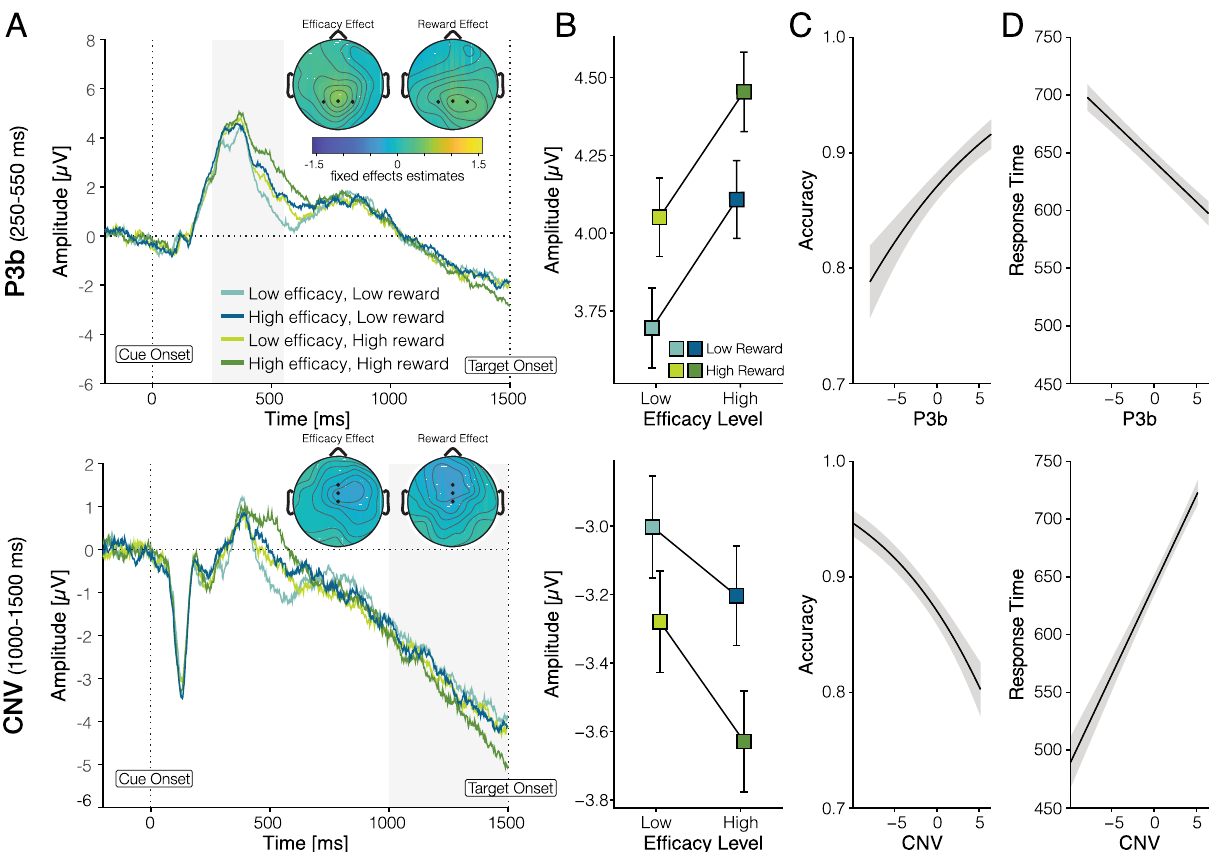
Fig. 4 P3b and contingent negative variation (CNV) amplitudes track increases in expected reward and ef fi cacy. A ERP averages for each incentive condition, separately for the P3b (top) and CNV (bottom). Shaded areas indicate time windows used for quanti fi cation. Topographies show group-level ( fi xed-effect) contrasts for reward and ef fi cacy, respectively. B Average ERP amplitudes within the relevant time windows show that the magnitude of the (positive-going) P3b and the (negative-going) CNV increase with greater reward and ef fi cacy. The CNV but not the P3b tracked the interaction of reward and ef fi cacy, mirroring the behavioral effects of these incentives (cf. Fig. 3). Error bars represent the within-subject standard error of the mean. C , D Fixed (group-level) effects of ERP amplitude on accuracy ( C ) and accurate RT ( D ) show that increased P3b and CNV predicted better performance when the target appeared. Shaded error bars represent the standard error of the mean. A – D n = 44 participants. Source data are provided as a Source Data fi